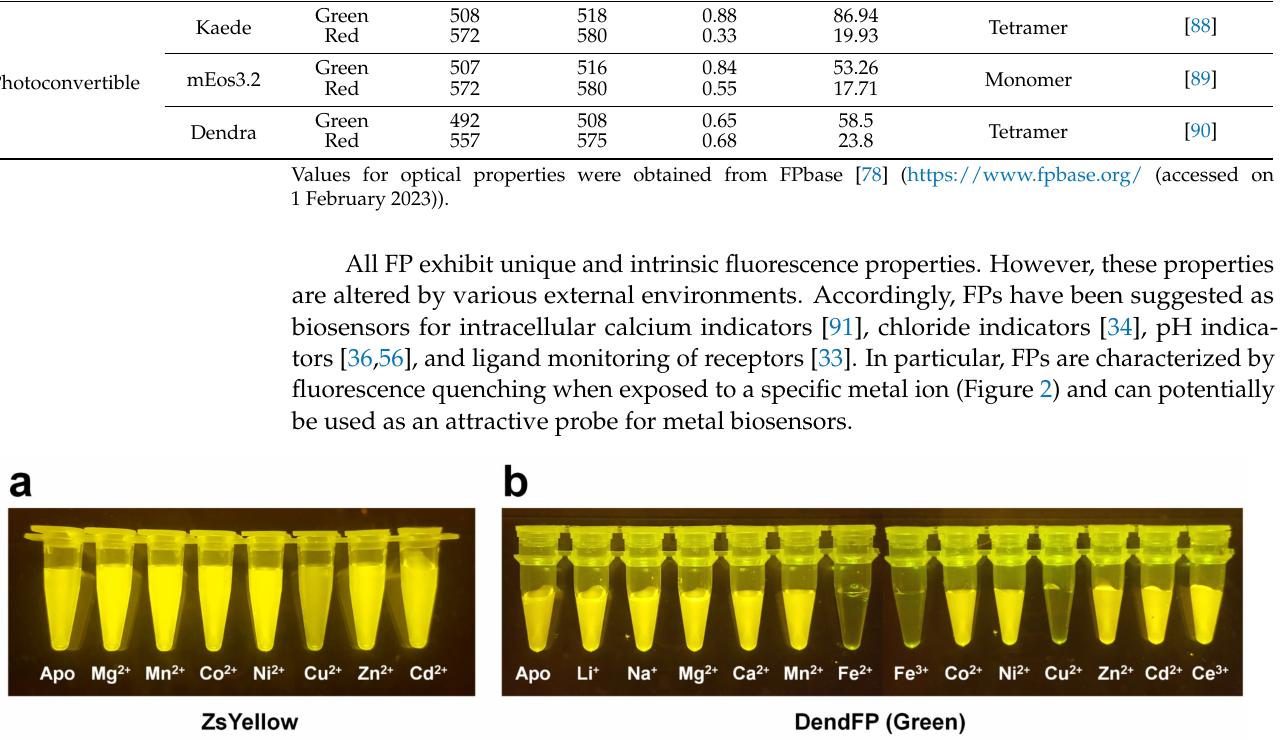
Figure 2. Visualization of quenchable metal ion screening for fluorescent proteins. Fluoresce quench- ing of ( a ) ZsYellow and ( b ) DendFP by metal ions. Original figures were obtained from previous studies for ZsYellow [92] and DendFP